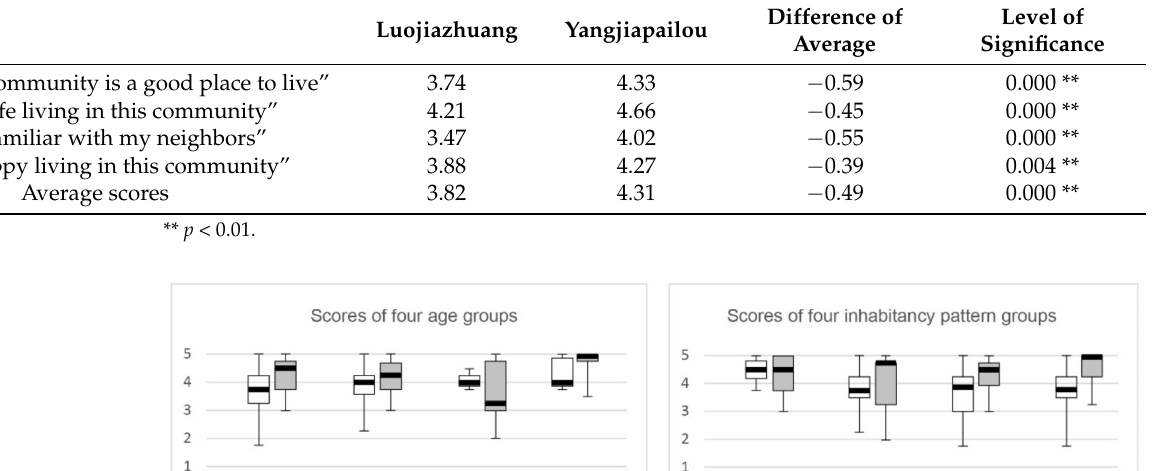
Table 4. Residential satisfaction in Luojiazhuang and Yangjiapailou.